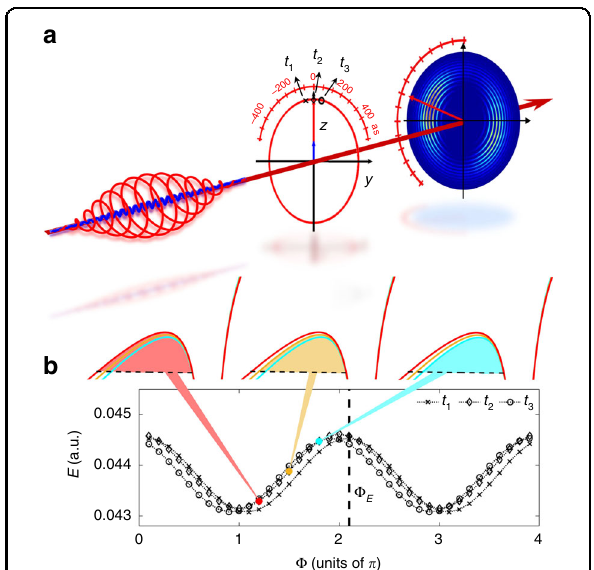
Fig. 1 Attosecond-scale streaking scheme for measuring the tunneling ionization time. a An elliptically polarized 800-nm laser pulse maps the tunneling ionization time to the emission angle of the photoelectron in attoclock con fi gurations. A perturbative SH fi eld polarized along the major axis of the fundamental laser ellipse ( z axis) is added to precisely determine the tunneling ionization time of the photoelectron in the momentum distribution relative to the instant of the laser- fi eld maximum ( t 0 = 0). b The electric fi eld strength | E | for three instants, as indicated in ( a ), slightly oscillates with the relative phase Φ , revealing different phase delays of Φ E , as indicated by the vertical dashed line. The variation of the electric fi eld strength leads to a slight change of the tunneling barrier width. Due to the pronounced nonlinearity of tunneling ionization, the tunneling current will be strongly modulated by the relative